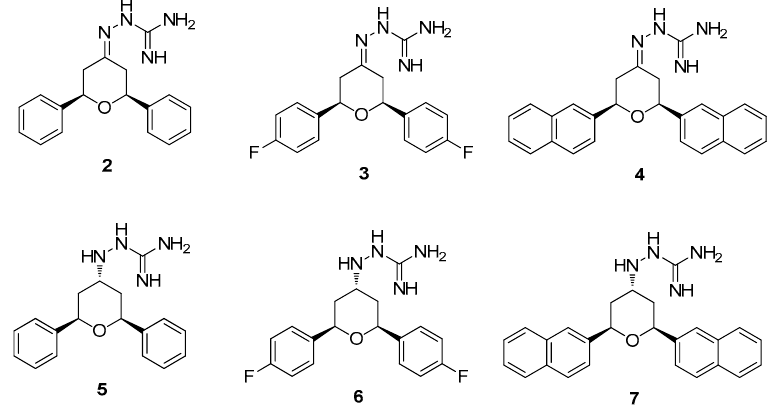
Figure 2. Compounds synthesized and evaluated against tumor cells line in this work .